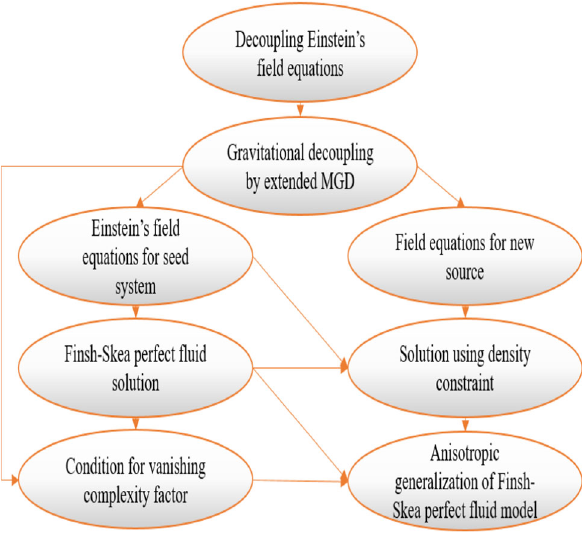
Fig. 1 The flow chart shows a simple protocol for generalizing the perfect fluid solution to the anisotropic domain under the vanishing complexity